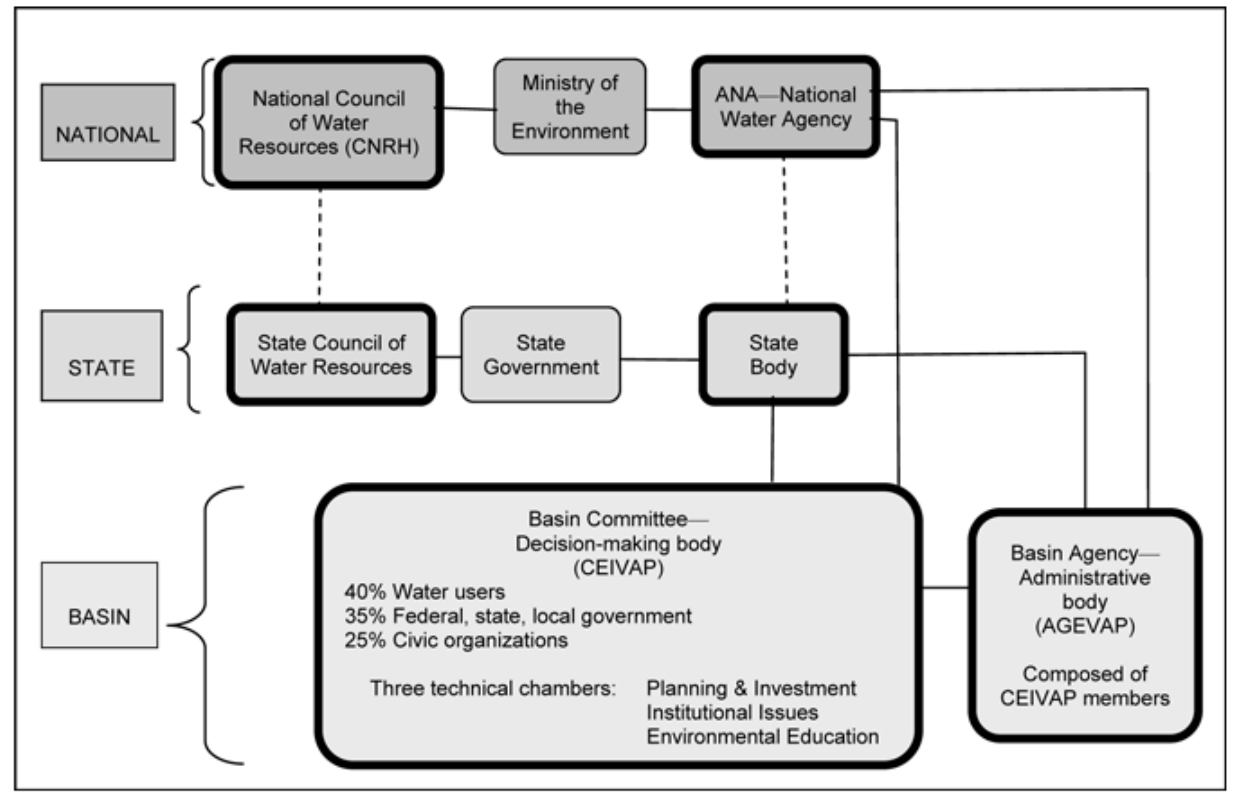
Fig. 1. Diagram of National Water Resources System (adapted from: Agência Nacional das Águas, October 2002). Bold boxes indicate organizational elements created after the Water